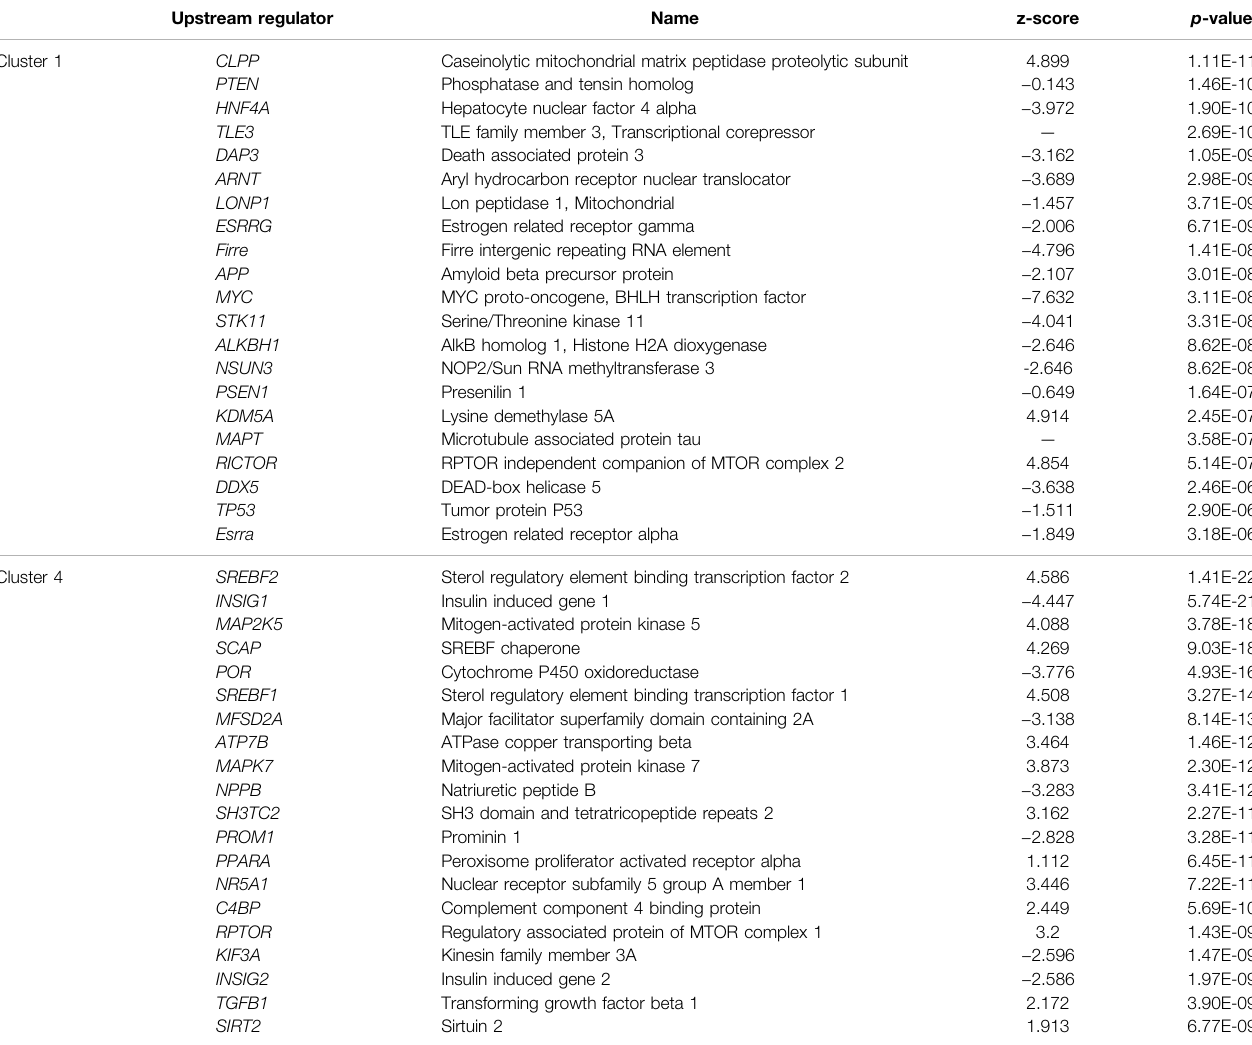
TABLE 4 | Top biological upstream regulators and their respective activation z-score as well as p -value of association for the strong clusters, cluster 1 and 4. Upstream